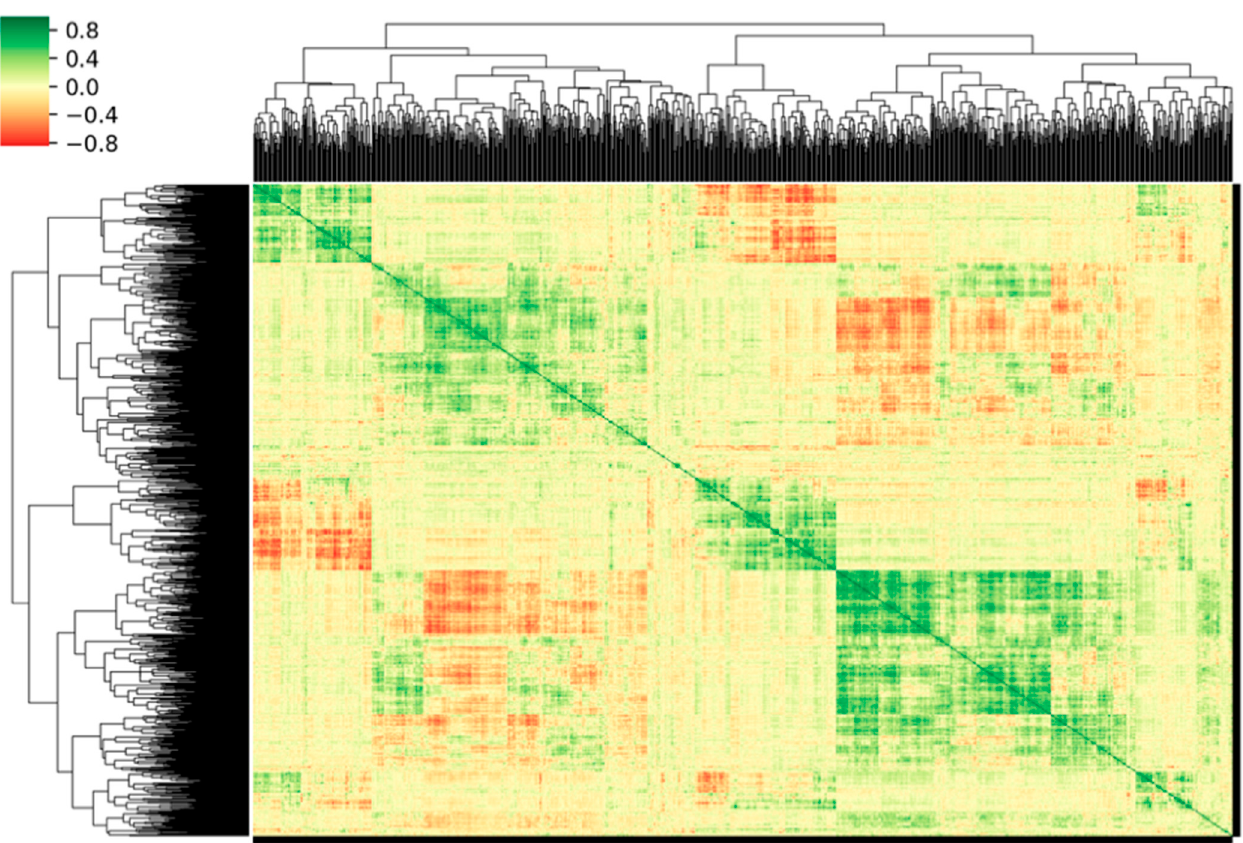
Figure 3. Cluster gram of significant correlations, expressed as the Pearson correlation coefficient, between the candidate features. Correlation degrees are colored according to the color bar shown on the left.